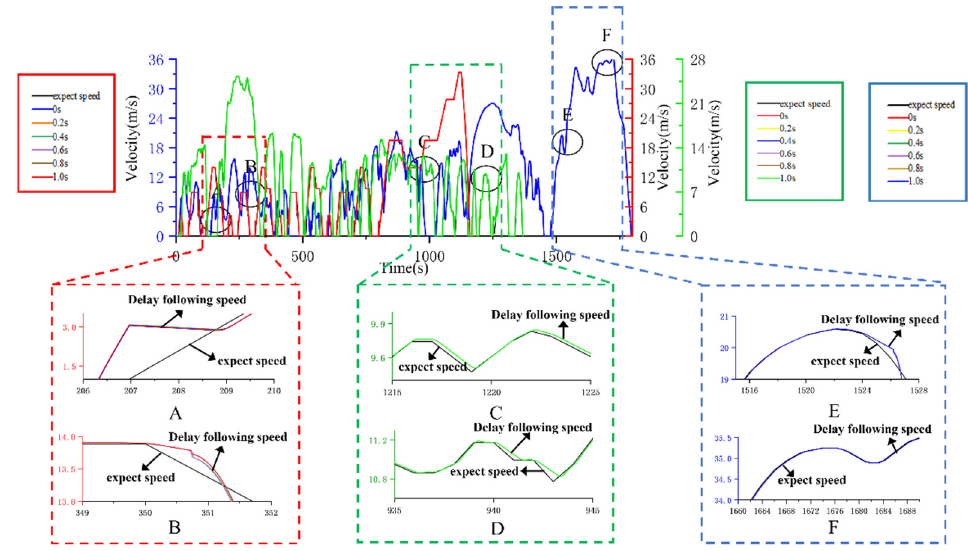
Figure 5. Velocity values under different delay times.